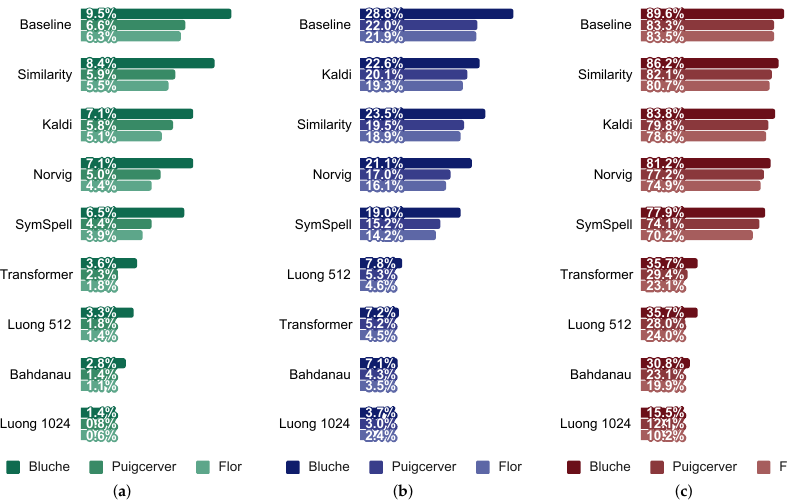
Figure 16. Error rates in the RIMES dataset (lower is better), ( a ) Character Error Rate (CER); ( b ) Word Error Rate (WER); ( c ) Sequence Error Rate (SER).